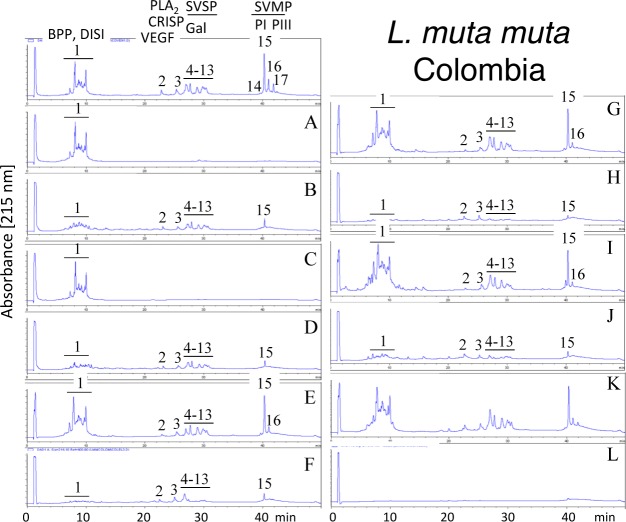
Immunoaffinity chromatography-based antivenomic analysis of the immunoreactivity of polyspecific and monospecific antivenoms towards the venom of L. muta muta from Colombia.Panels display reverse-phase separations of whole venom components, and non-retained (A, C, E, G, and I) and the retained (B, D, F, H, and J) fractions recovered, respectively, from the affinity columns of immobilized BCL, BL, AL, AB, and AC antivenoms. Panels K and L, non-retained and retained venom fractions by immobilized equine control immunoglobulins. CRISP, cysteine-rich secretory protein. Other protein acronyms as in the legend of Fig 2.